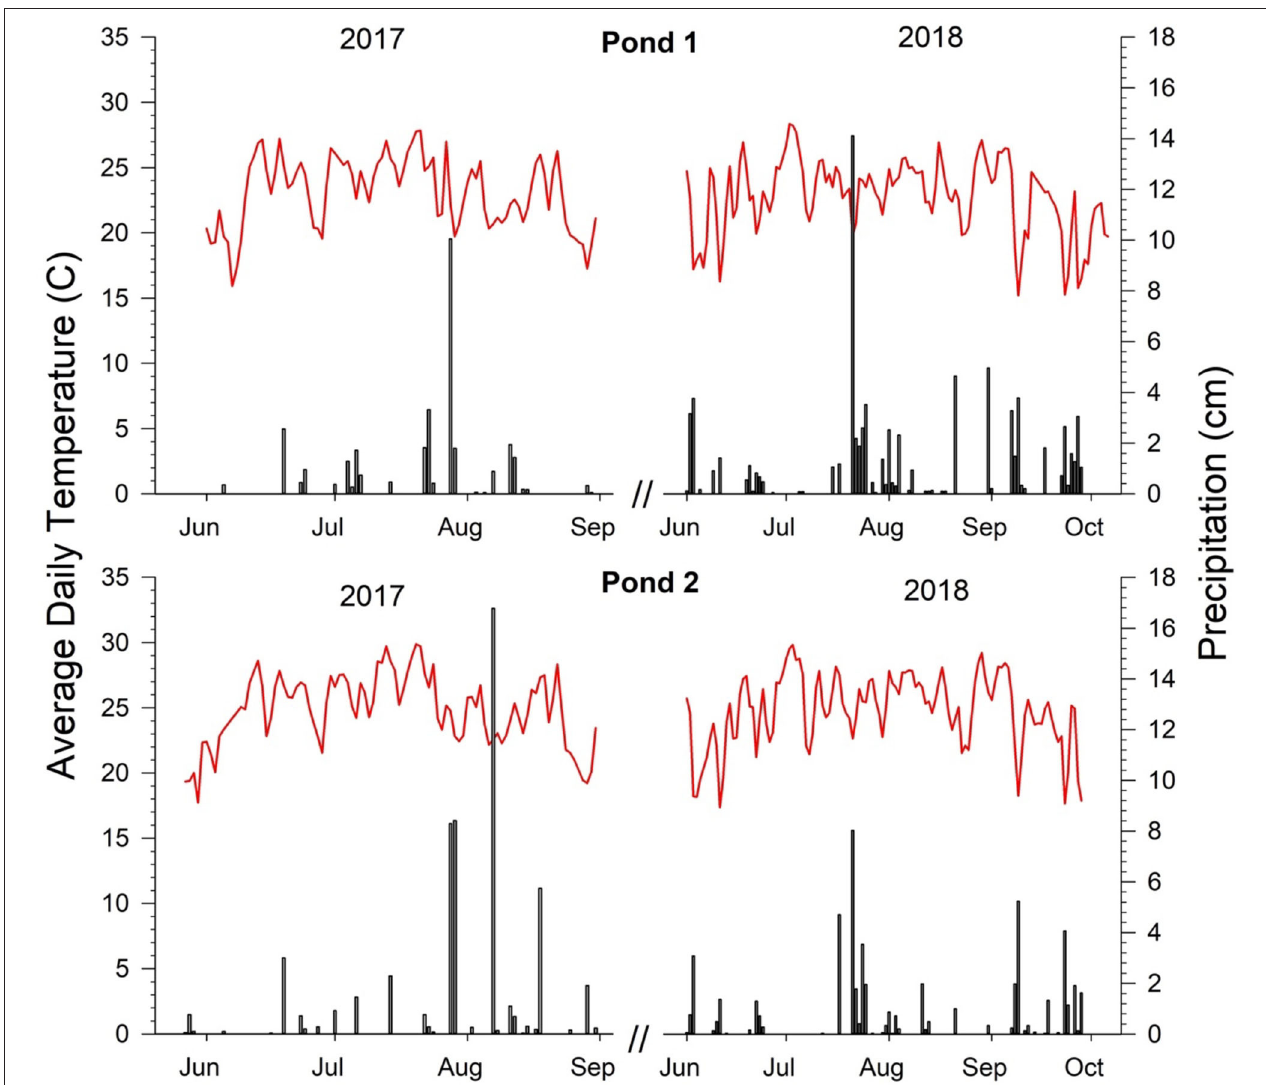
FIGURE 2 | Precipitation and ambient air temperature data for both ponds. Precipitation data is represented in bars and temperature data are shown with red